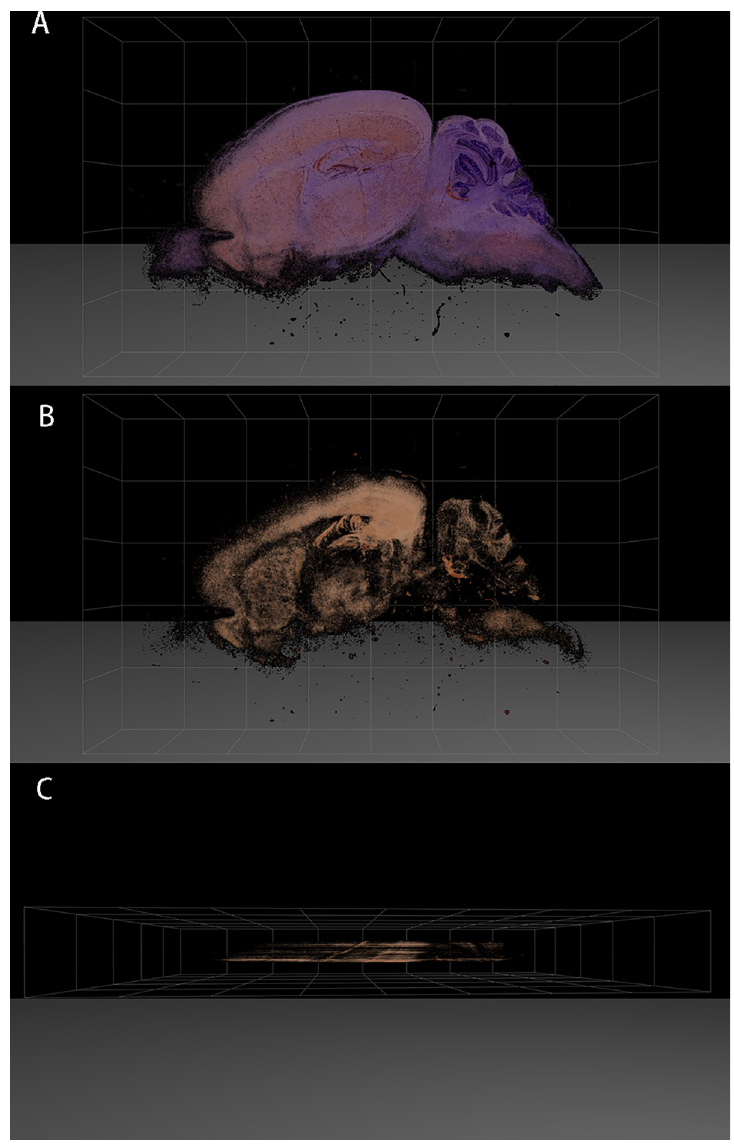
Fig 6. 3D localization of JEV in the mouse brain at 6 d post JEV infection. (A) 3D frontal image, from the mid- sagittal side of the brain outward, with the cerebrum on the left and the cerebellum on the right. (B) 3D frontal image with background removed, showing immunohistochemical staining of the virus antigen (brown). (C) 3D overhead view with the background removed, showing staining of the virus antigen